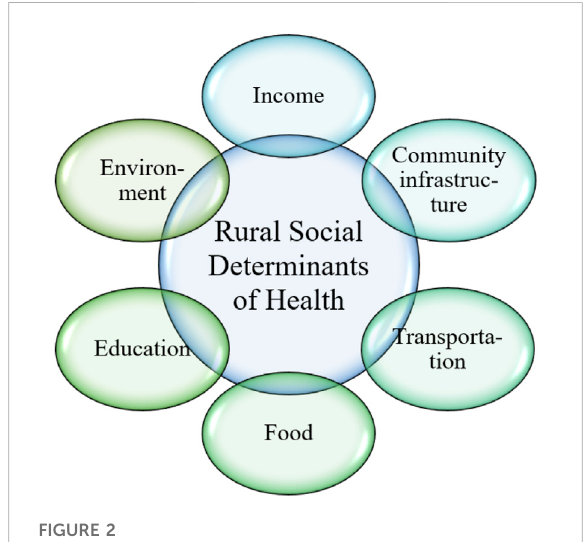
FIGURE 2 Rural social determinants of